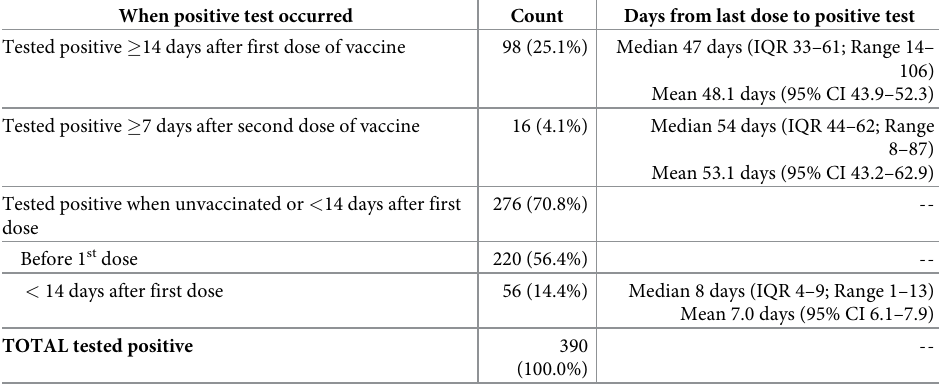
Table 2. COVID-19 positive tests after vaccination in VCH HCWs from December 15, 2020. When positive test occurred